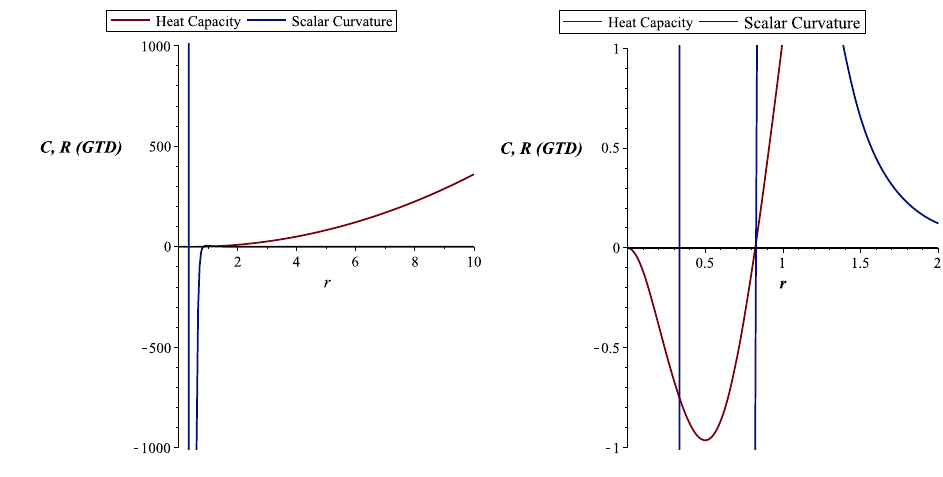
Fig. 11 Heat capacity and scalar curvature for GTD geometry against horizon